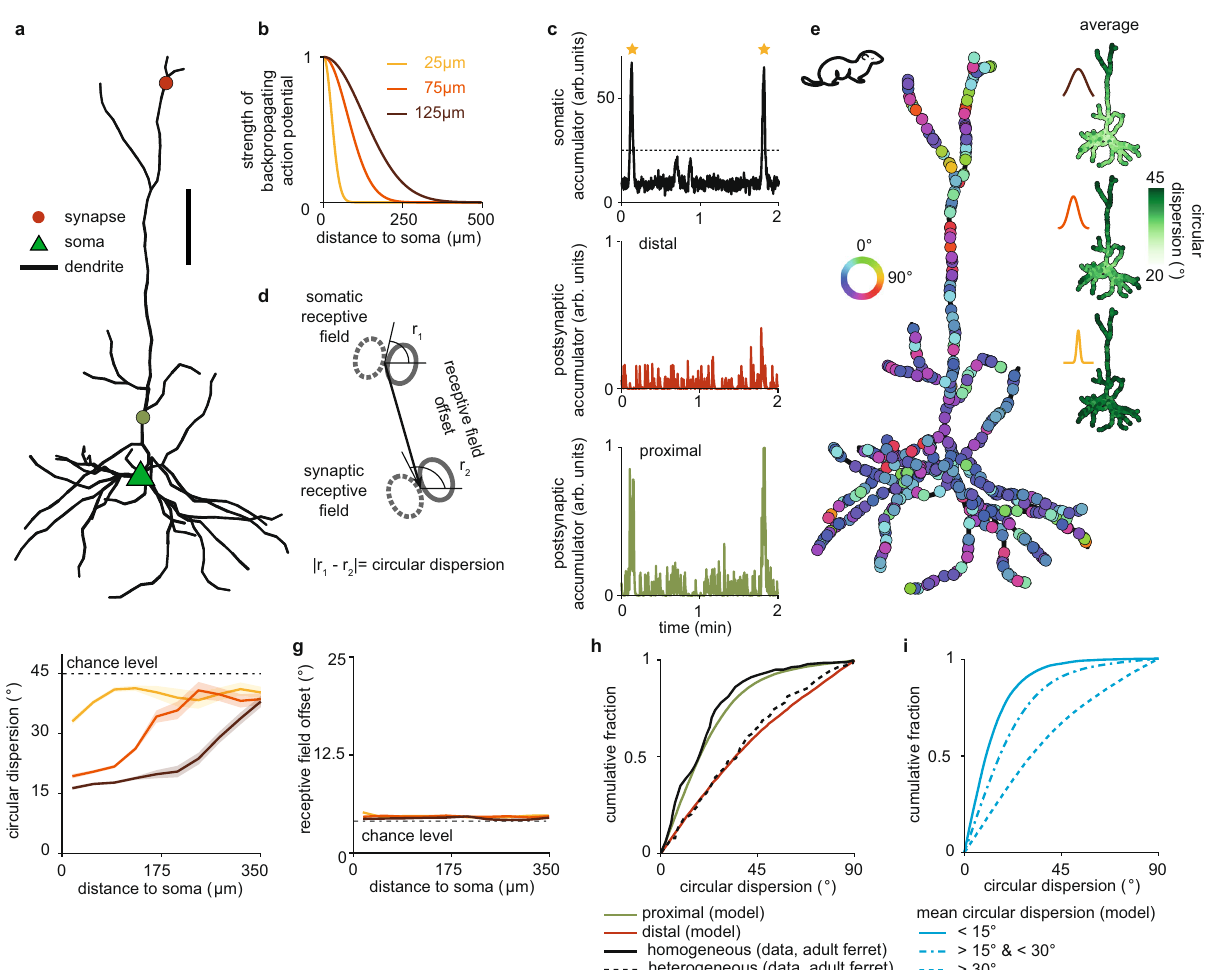
Fig. 5 A backpropagating somatic signal drives heterogeneously and homogeneously clustered dendritic branches in a model of the ferret visual cortex. a Illustration of a reconstructed pyramidal cell from layer 2/3 (Allen Cell Type database, ID 502269786). Triangle indicates soma. Circles indicate synaptic sites. Scale bar is 50 μ m. b Strength of backpropagating action potentials (bAPs) for different attenuation factors as a function of path distance from the soma. c Top: Sample trace of somatic activation under retinal wave stimulation after fi ve simulated days. Asterisks indicate the initiation of multiple global somatic signals in the form of a burst of bAPs after threshold crossing (dashed line). Middle, Bottom: Postsynaptic calcium traces of a distal (middle) and a proximal (bottom) synapse (indicated in a ). d Schematic to illustrate circular dispersion and receptive fi eld offset (see Methods). e Emergence of global organization of orientation preference on the reconstructed pyramidal cell using ferret cortex receptive fi eld spread and diameter. Color of synapses indicates the orientation preference of the associated receptive fi eld. Inset shows the circular dispersion averaged over 62 simulations for the three different attenuation factors in ( b ). f , g Circular dispersion ( f ) and receptive fi eld offset ( g ) between synapse and soma for the three different bAP attenuation factors in ( b ) and as a function of path distance from the soma. Shaded areas indicate 95% con fi dence interval around the mean. h Cumulative fraction of circular dispersion for one bAP attenuation factor (75 μ m) in the model, and different types of clustered branches in experiments (data from adult ferret visual cortex reproduced from ref. 7 ). i Same as h for branches with low (<15°), intermediate (15° – 30°), and high (>30°) mean circular dispersion in the